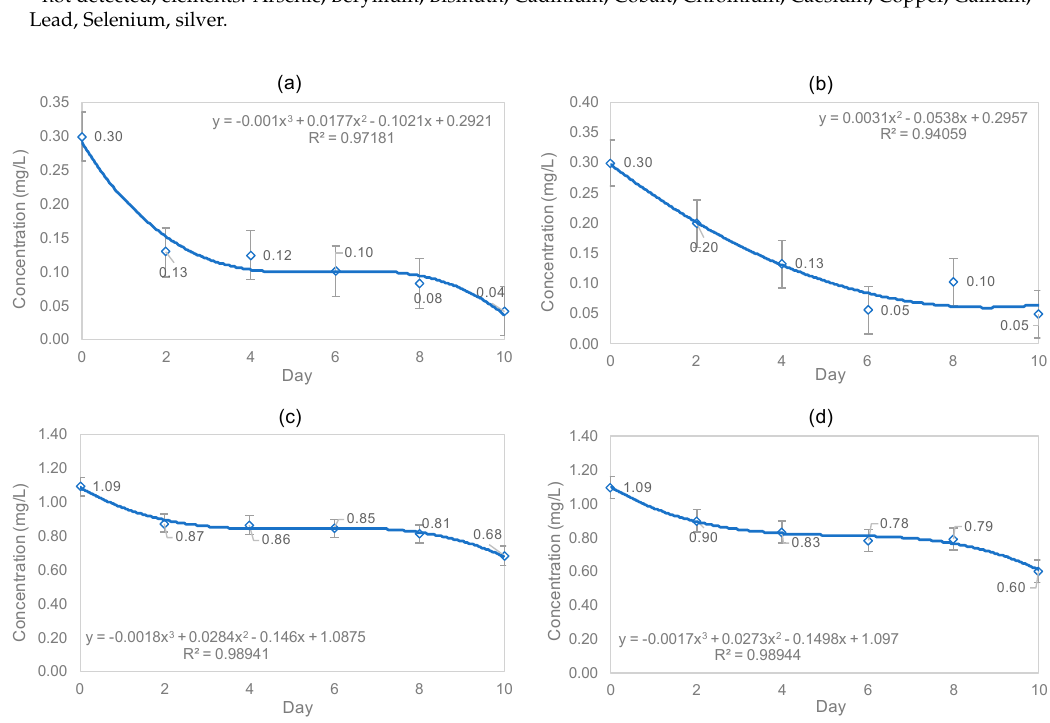
Figure 3. Reduction of: ( a ) Al concentration by Ipomoea aquatica ; ( b ) Al concentration by Centella asiatica ; ( c ) Fe concentration by Ipomoea aquatica ; and ( d ) Fe concentration by Centella asiatica.